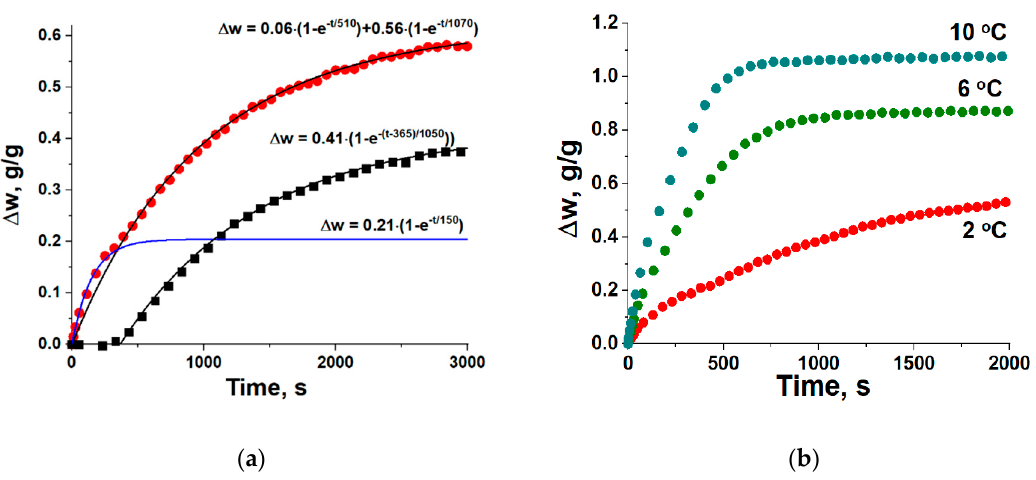
Figure 6. ( a ) Fast and slow components of methanol release curve at T M = 2 °C; ( b ) methanol release curves measured at various T M listed near the curves. Composite LiCl / MWCNT. Table 6. Characteristic times τ , τ 0.7 , τ 0.8 and specific powers W max , W 0.7 , and W 0.8 for